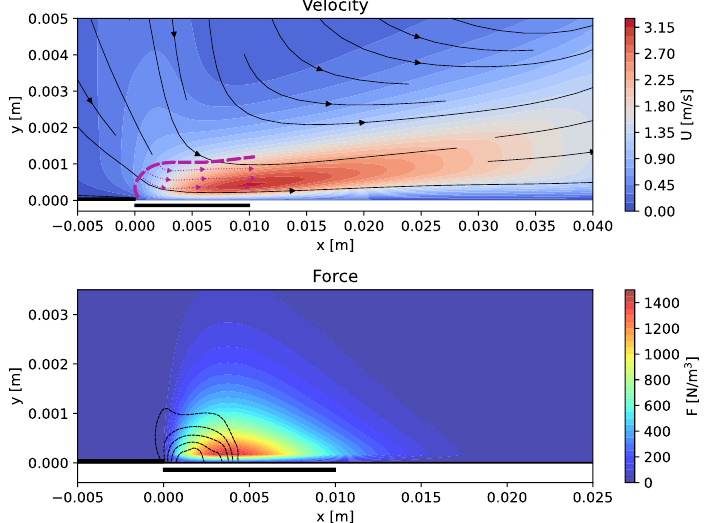
Figure 8. Modified Dörr and Kloker model velocity field ( top ) and force ( bottom ) at 12 kV and 2 kHz. Purple lines and arrows are the reference wall jet, black arrows are the streamlines of the numerical